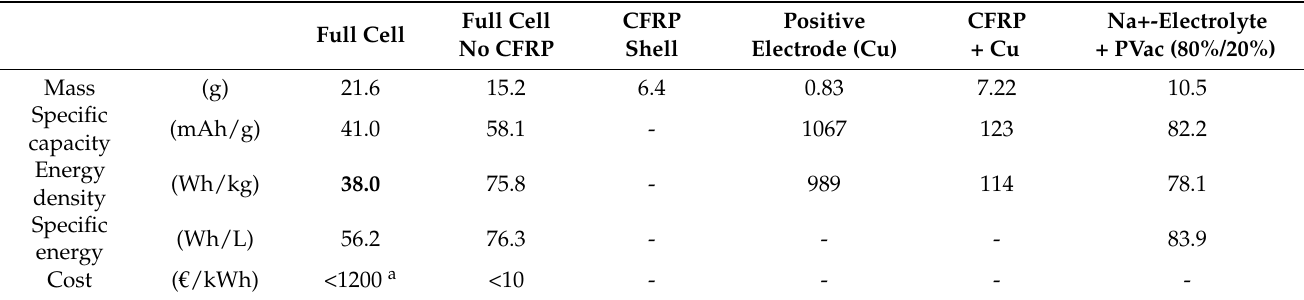
Table 2. All-solid-state coaxial structural battery